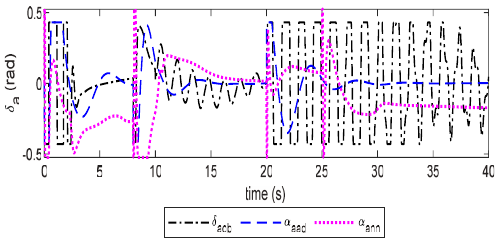
Figure 10. Control surface deflection angles of δ a .